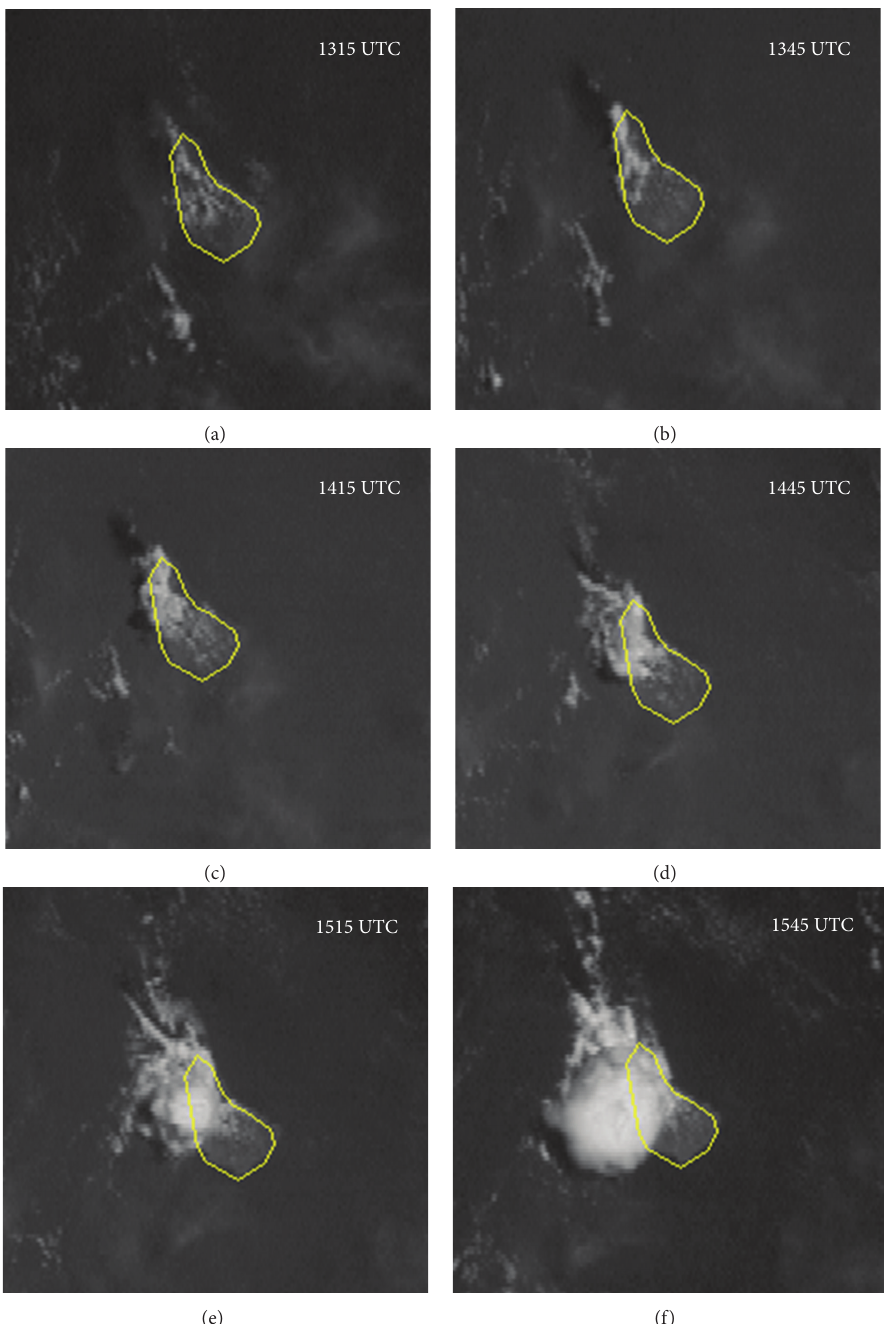
Figure 2: The time series from 1315UTC to 1545 UTC of visible satellite imagery (RAMSDIS-CIRA/RAMM) at 1km resolution centered over